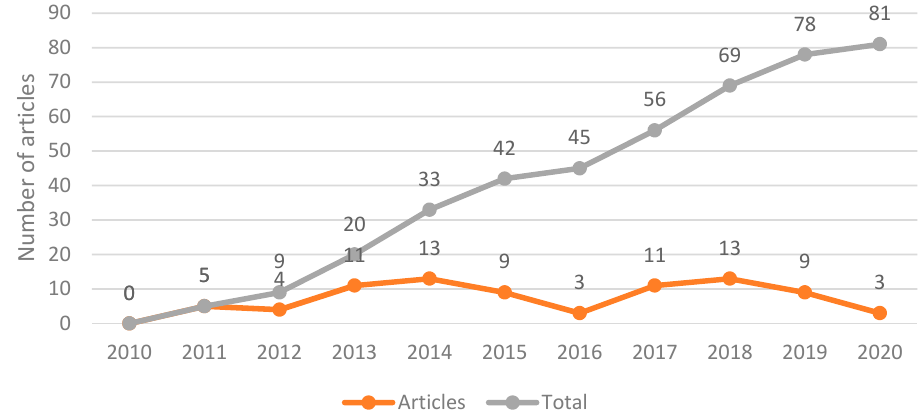
Figure 2. Distribution of articles by year of publication.